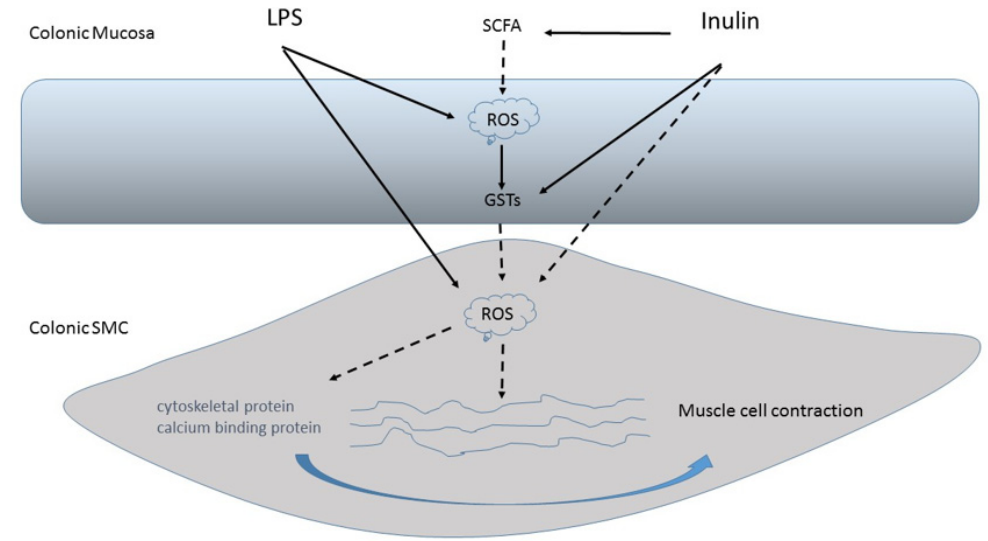
Figure 1. The antioxidant action of inulin-type fructans on colon mucosa and contractility. Inulin, through short-chain fatty acids, can act as a scavenger of reactive oxygen species (ROS). Inulin is also able to modulate responses to pathogenic bacterial insults (Lipopolysaccharide (LPS)) and protect gut from inflammatory processes, probably stimulating defenses against ROS by up-regulating colonic mucosal detoxification enzymes (GSTs), and in this way, inulin restores the level of some important proteins involved in intestinal smooth muscle contraction. Dotted line: inhibitory action. Solid line: stimulatory action. LPS, Lipopolysaccharide. ROS, reactive oxygen species. GSTs, glutathione S-transferases. SCFA, short-chain fatty acids.